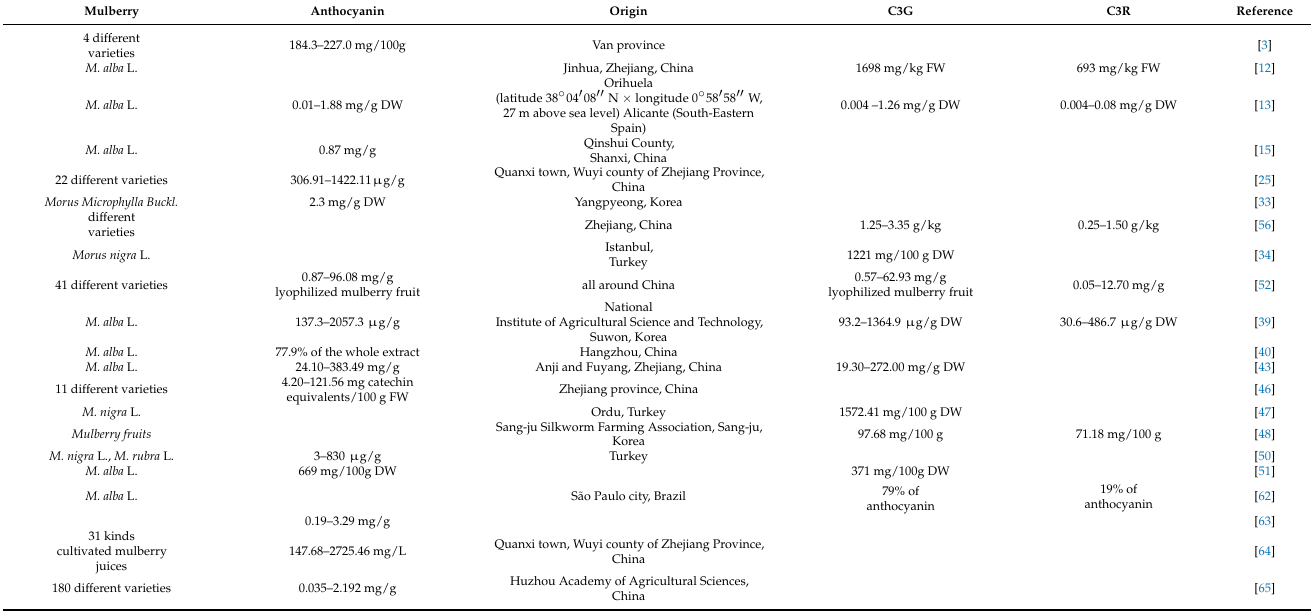
Table 2. Anthocyanin in